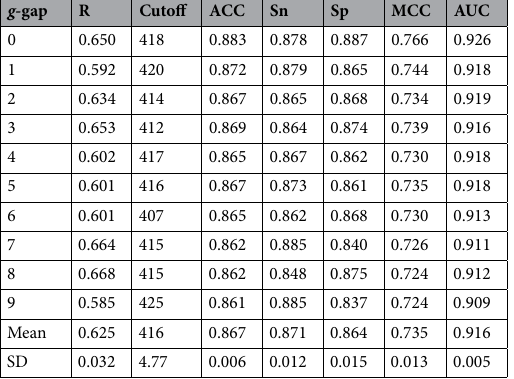
Table 2. Cross-validation results of SCM models using different optimal propensity scores of g -gap dipeptides.